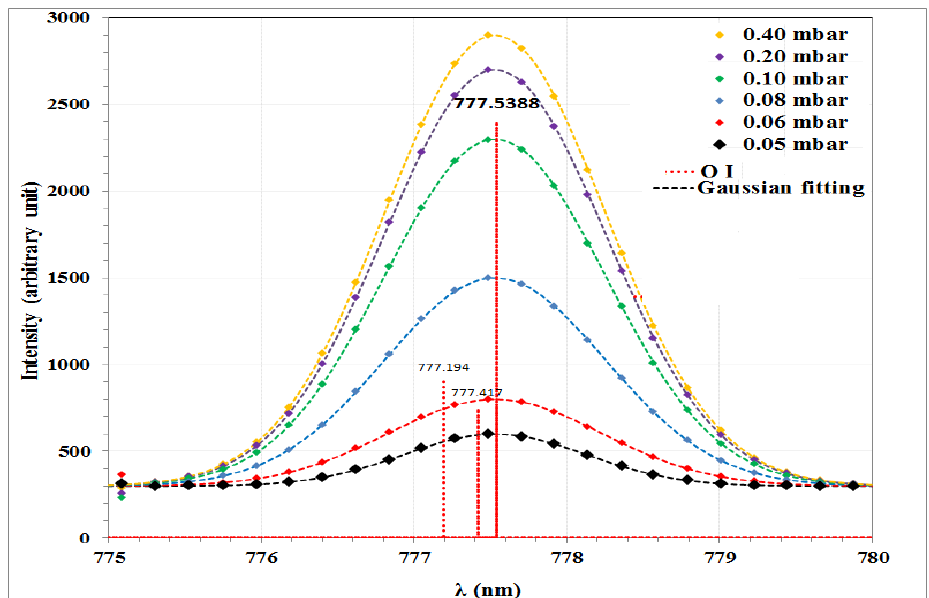
Fig. 6: Cu I 324.754 nm peaks broadening and there Gaussian fitting at different pressure.